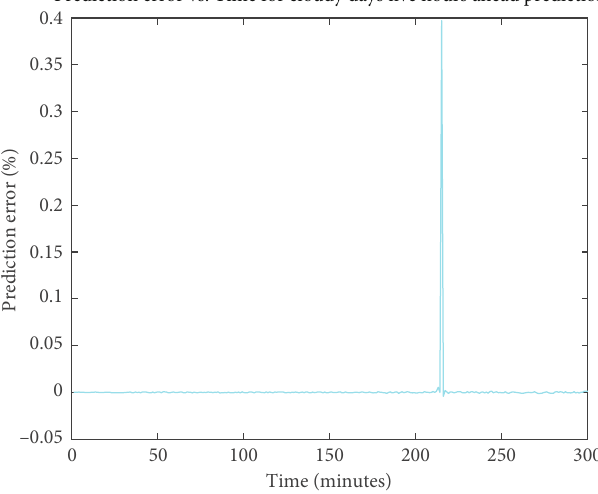
Figure 35: Prediction error vs. time for cloudy day fi ve-hour-ahead